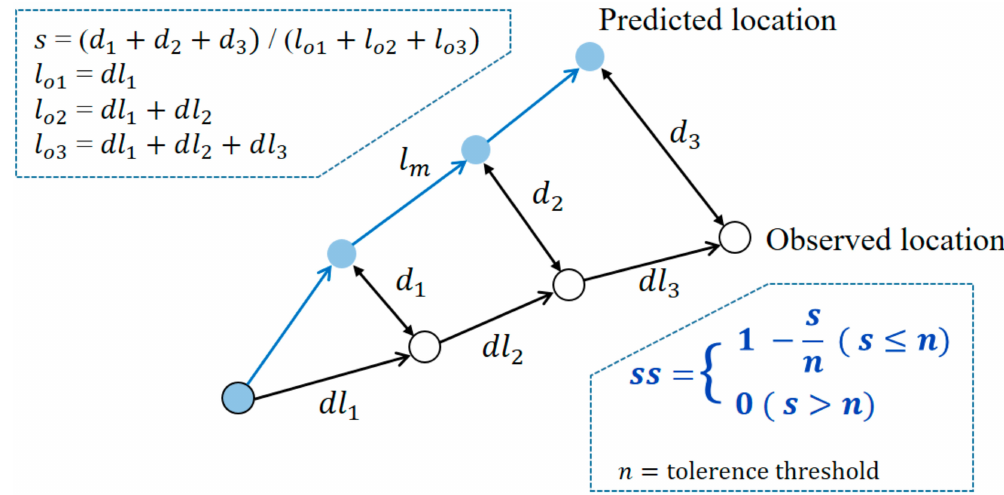
Figure 4. Formula to calculate skill score ( ss ) of NCLS.